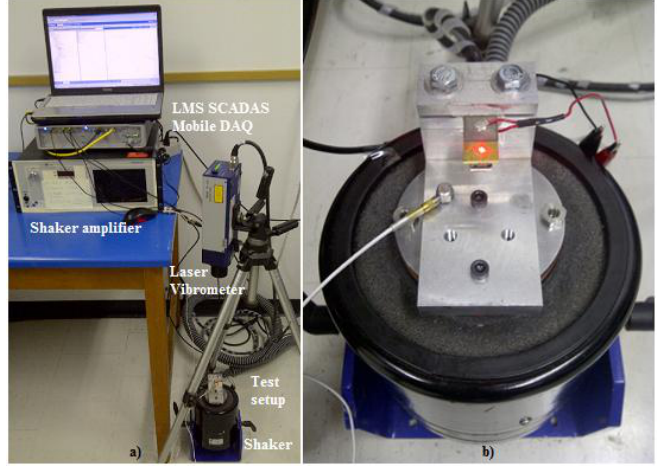
Figure 16. Sensor modal testing setup. ( a ) Overview of setup; ( b ) Close-up of sensor mounted on the electromechanical